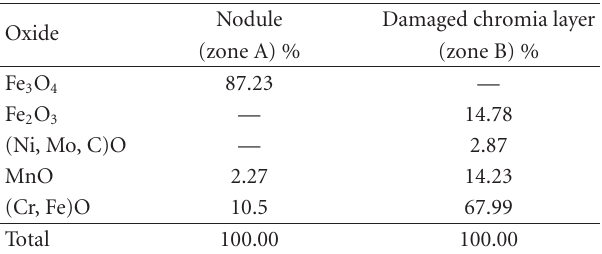
Table 3: EDX spectra results of large and small nodules for AISI 316 at T = 1000 ◦